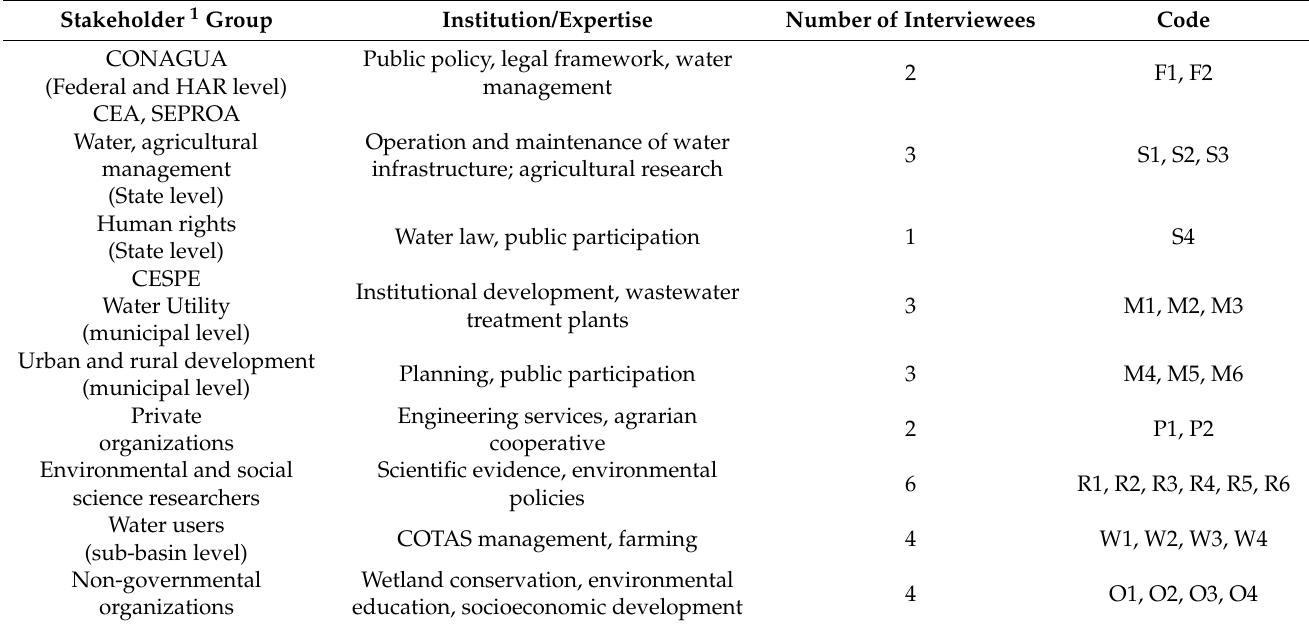
Table 2. List of stakeholders (type of actor, institution,